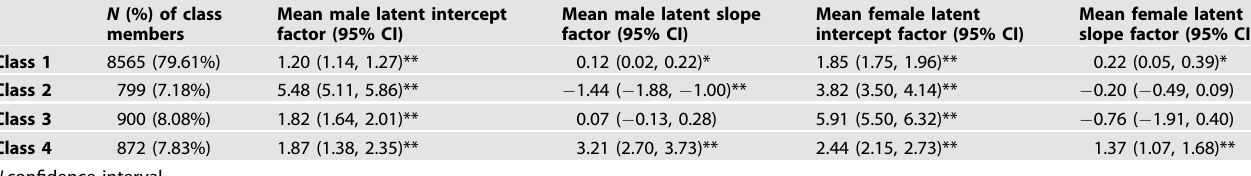
Table 1. Class proportions and mean intercept and slope results in the 4-class dyadic latent base growth model.